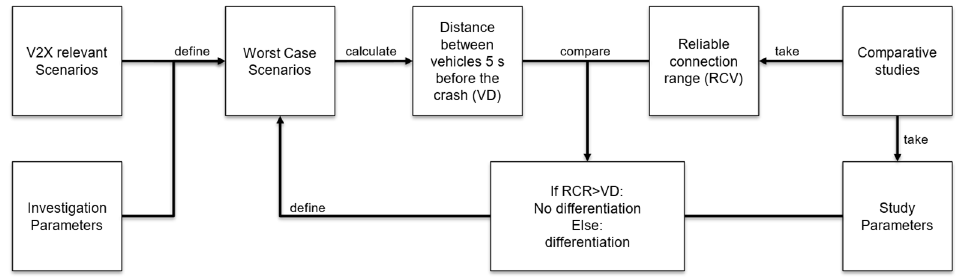
Figure 1. Schematic representation of the method used to determine the need for differentiation of V2X radio transmission technology. V2X radio transmission